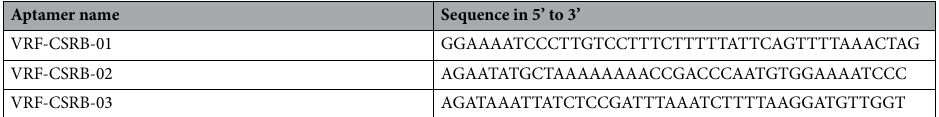
Table 1. Oligonucleotide sequences of selected aptamer candidates. Top three from most frequent oligonucleotide sequences obtained after next-generation sequencing (NGS) of the 26th Cell-Selex cycle. Only the sequence corresponding to the random region is